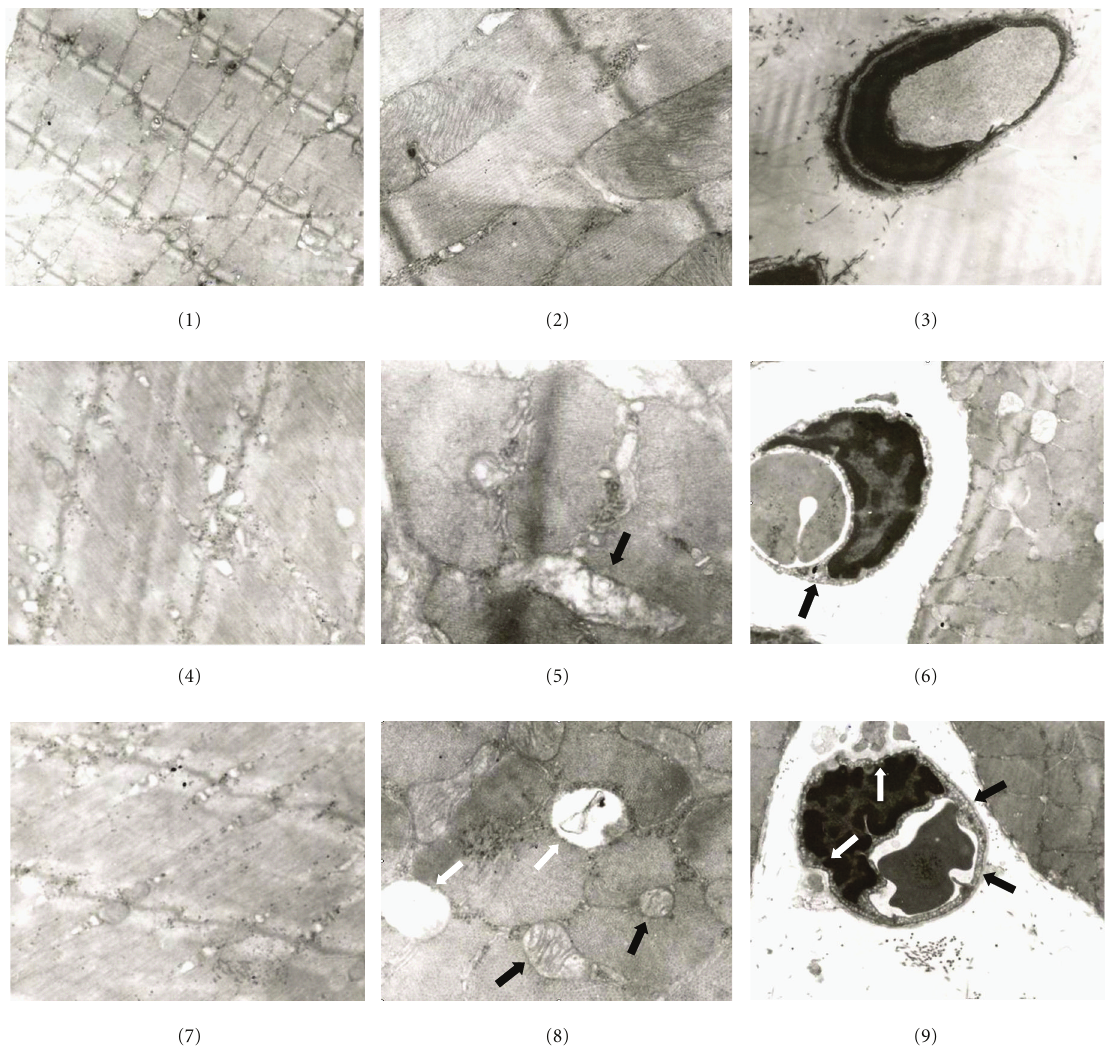
Figure 4: Electron microscopy of masticatory muscles. Shown are the ultrastructures of the masticatory muscles observed by transmission electron microscopy at a magnification of 8000X (panel 1, 2, 4, 5, 7, and 8) and 25000X (panel 3, 6, and 9). Panels 1, 2, and 3 refer to the control group (CON). Panels 4, 5, and 6 refer to the psychological group (PS) after three weeks of stimulation. Panels 7, 8, and 9 refer to PS after five weeks of stimulation. Swollen mitochondria with cristae loss and reduction of matrix density were found in the masticatory muscles of PS rats after three weeks or five weeks of stimulation, as marked by black arrows in Panel 5 and 8. Dramatic vacuolar changes in mitochondria appeared in PS rats after five weeks of stimulation, as marked by white arrows in Panel 8. The ultrastructure of capillaries in both control (Panel 3) and 3-w PS specimens (Panel 6) were generally normal, except a few signs of electron density decrease in the capillary cells, as marked by black arrow in Panel 6. Cytoplasm of some capillary cells of 5-w PS rats appeared to be more electron-lucent than those in control specimens, as marked by black arrows in Panel 9. Some places of the capillary basal laminae became accidented, with significantly increased exudation around, as marked by white arrows in Panel